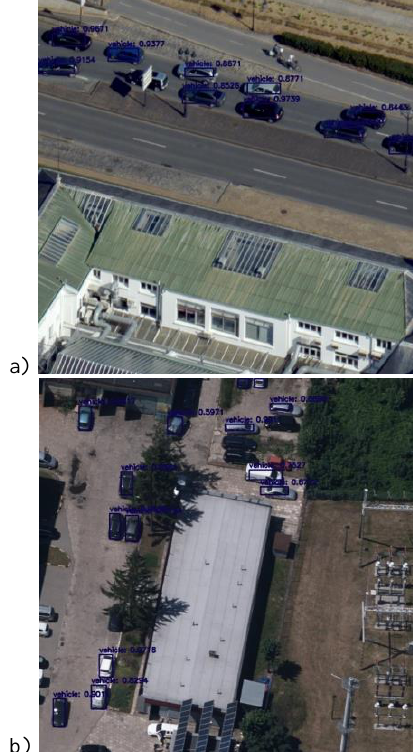
Figure 3 Results of the second experiment - object detection with the YOLO algorithm learned on DIOR images: a) Bordeaux, b)